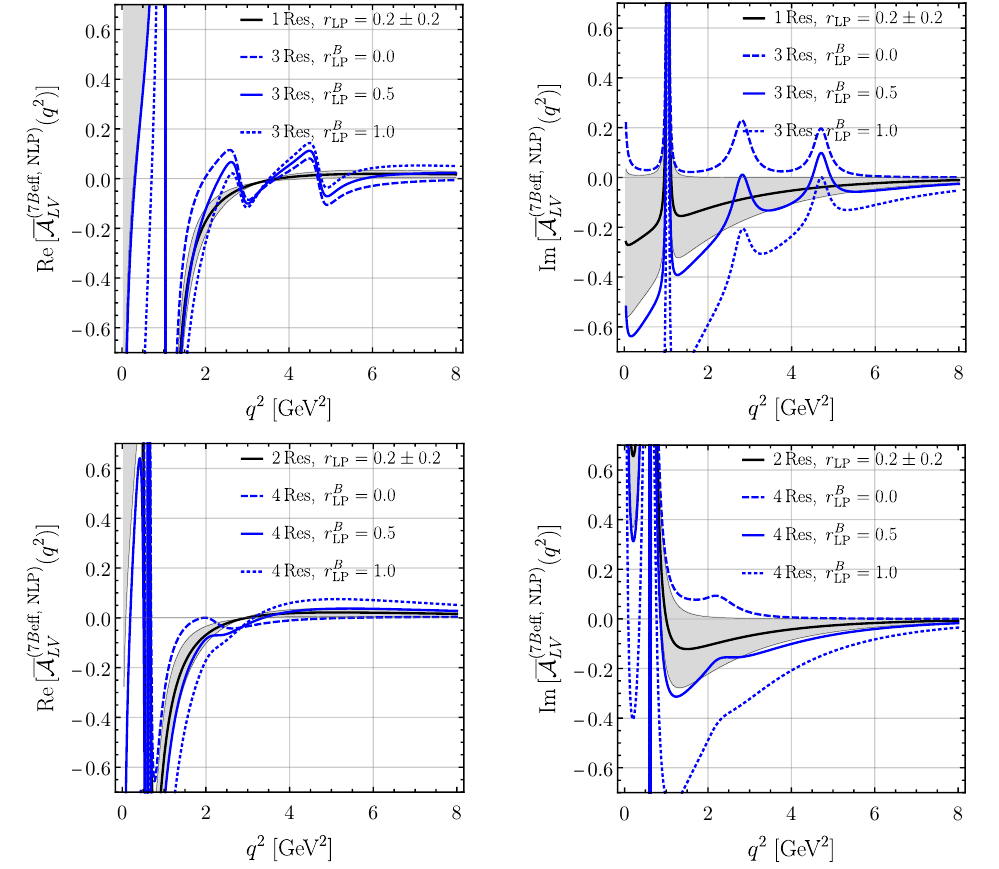
Figure 7 . The real [left] and imaginary [right] parts of the NLP local + nonlocal 7 B eff-type contributions i = 7 B eff to A LV for q = s [upper] and q = d [lower]. The default 1(2)-Res model for r LP = 0 . 2 ± 0 . 2 [grey band] is compared with the 3(4)-Res model for r B dashed, solid,